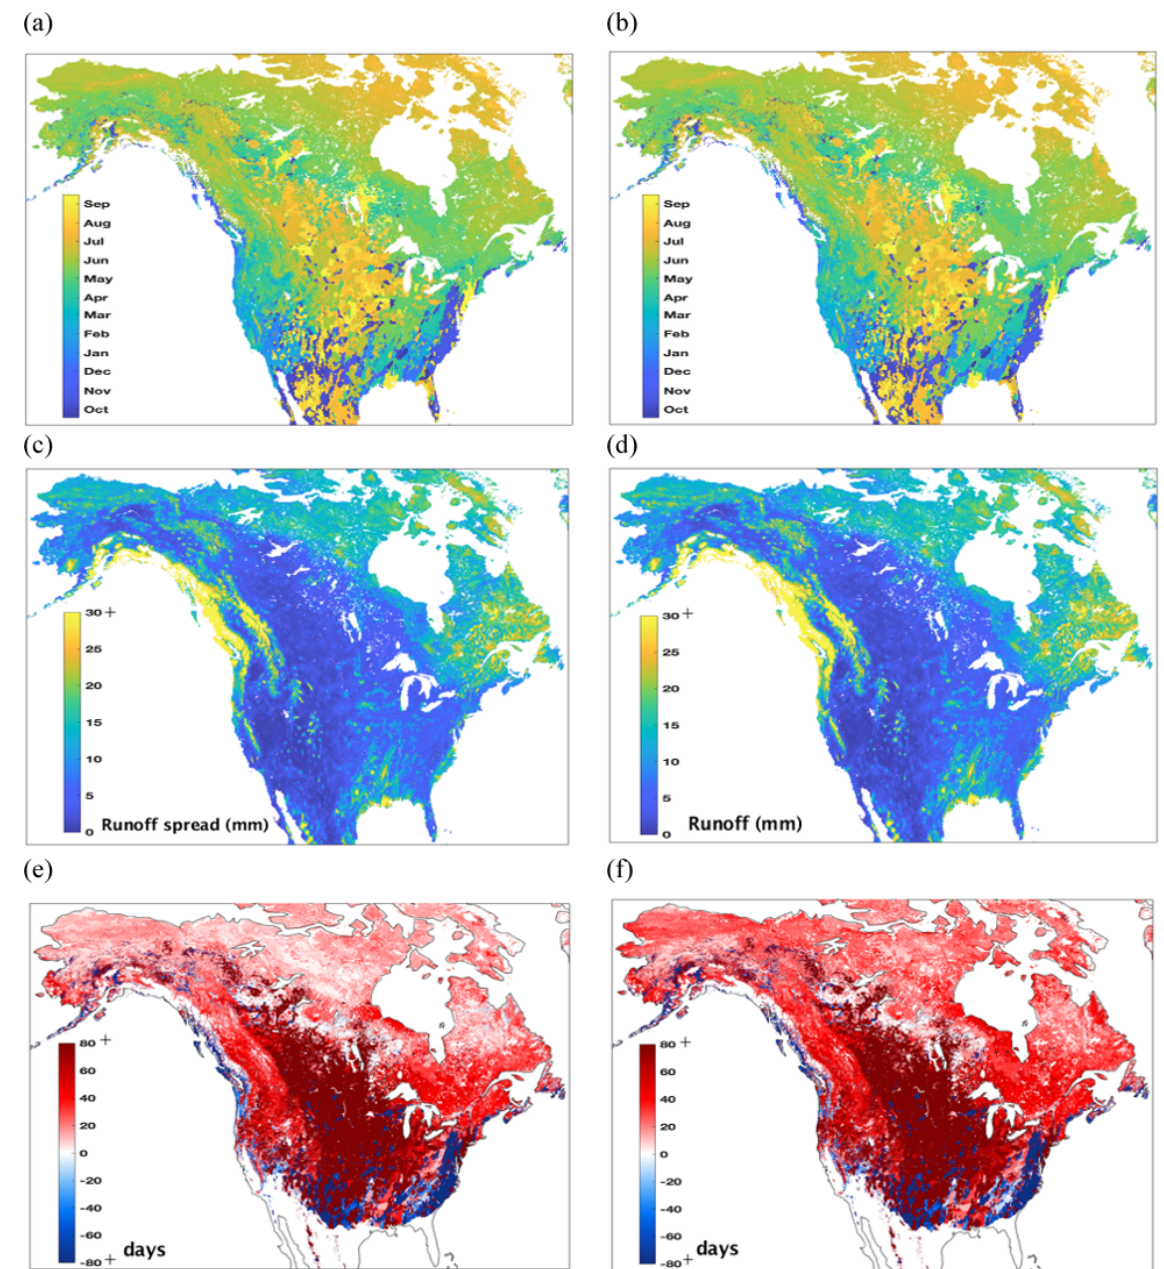
Figure 11. Spatial distributions of (a) the average day of year (DOY) with the highest ensemble R spread, (b) the average DOY with the peak R , (c) the highest R spread amount, (d) the peak R amount, (e) the difference of average DOY between the highest R spread and the highest SWE spread, and (f) the difference of average DOY between the peak R and the peak